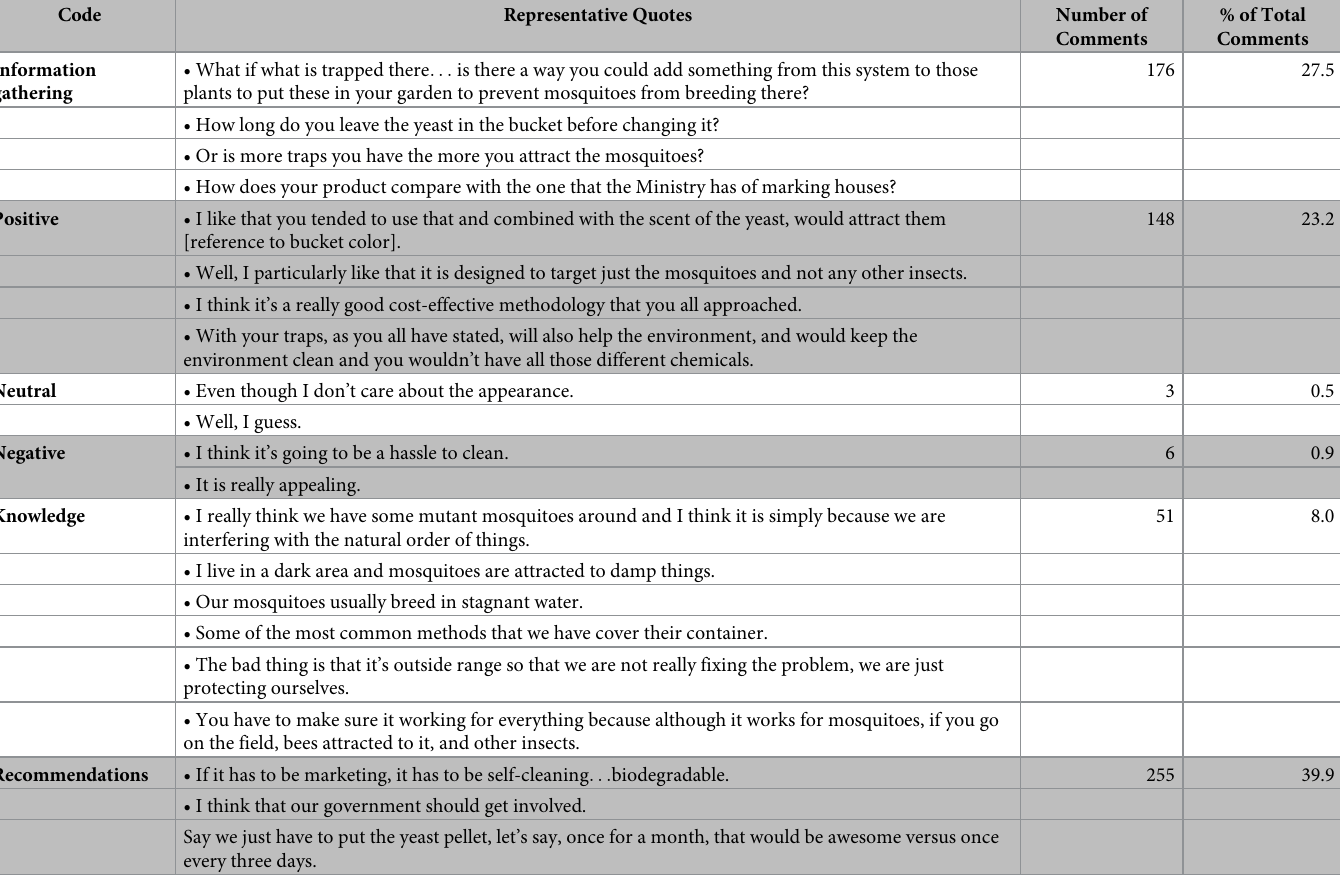
Table 2. Analysis of the community engagement forum transcript